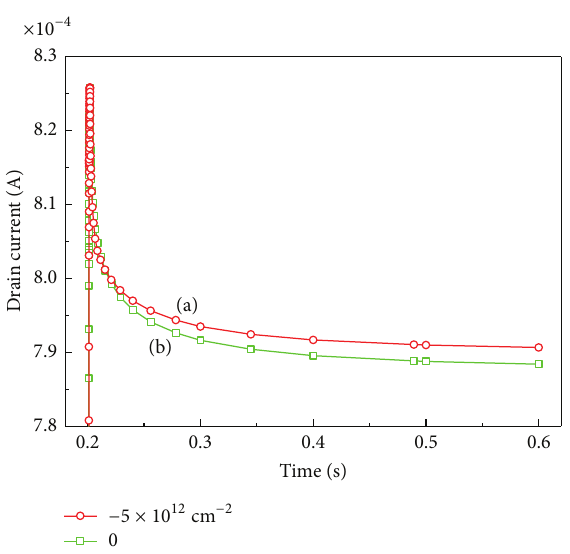
Figure 4: Comparison of drain current versus pulse time. The curves of drain current are shifted to hold two peaks together for better comparison.